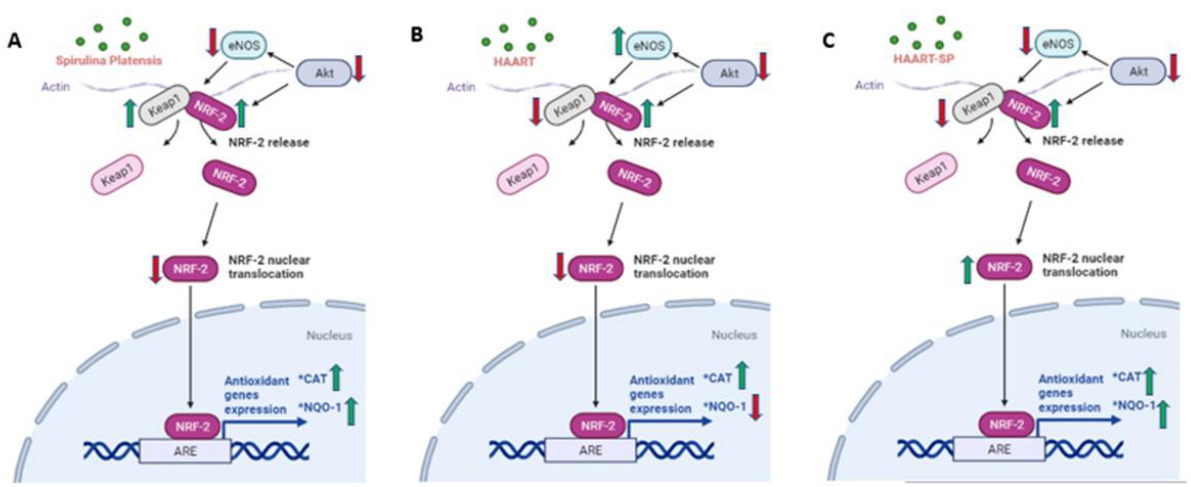
Figure 9. Effects of Spirulina platensis and HAART (3TC, TDF, and FTC) on antioxidant induction pathway in HepG2 cells; ( A ): the effect of Spirulina platensis ; ( B ): the effect of HAART; ( C ): the effect of HAART-SP (created with BioRender.com).